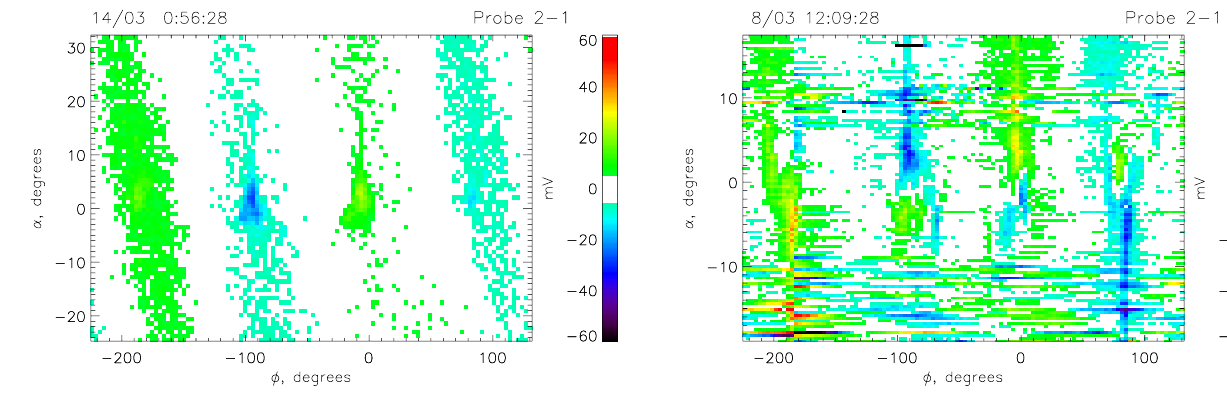
Fig. 16. (φ,α) map of disturbances in the EMMA probes potentials fo Case 4. Broad smooth increases are evident at − 180 ◦ when probe 1 is ahead of the satellite, and at 90 ◦ , when probe 2 is ahead of the satellite. In the regions behind the satellite, narrower and more structured increases are seen at 0 ◦ and − 90 ◦ , respectively.